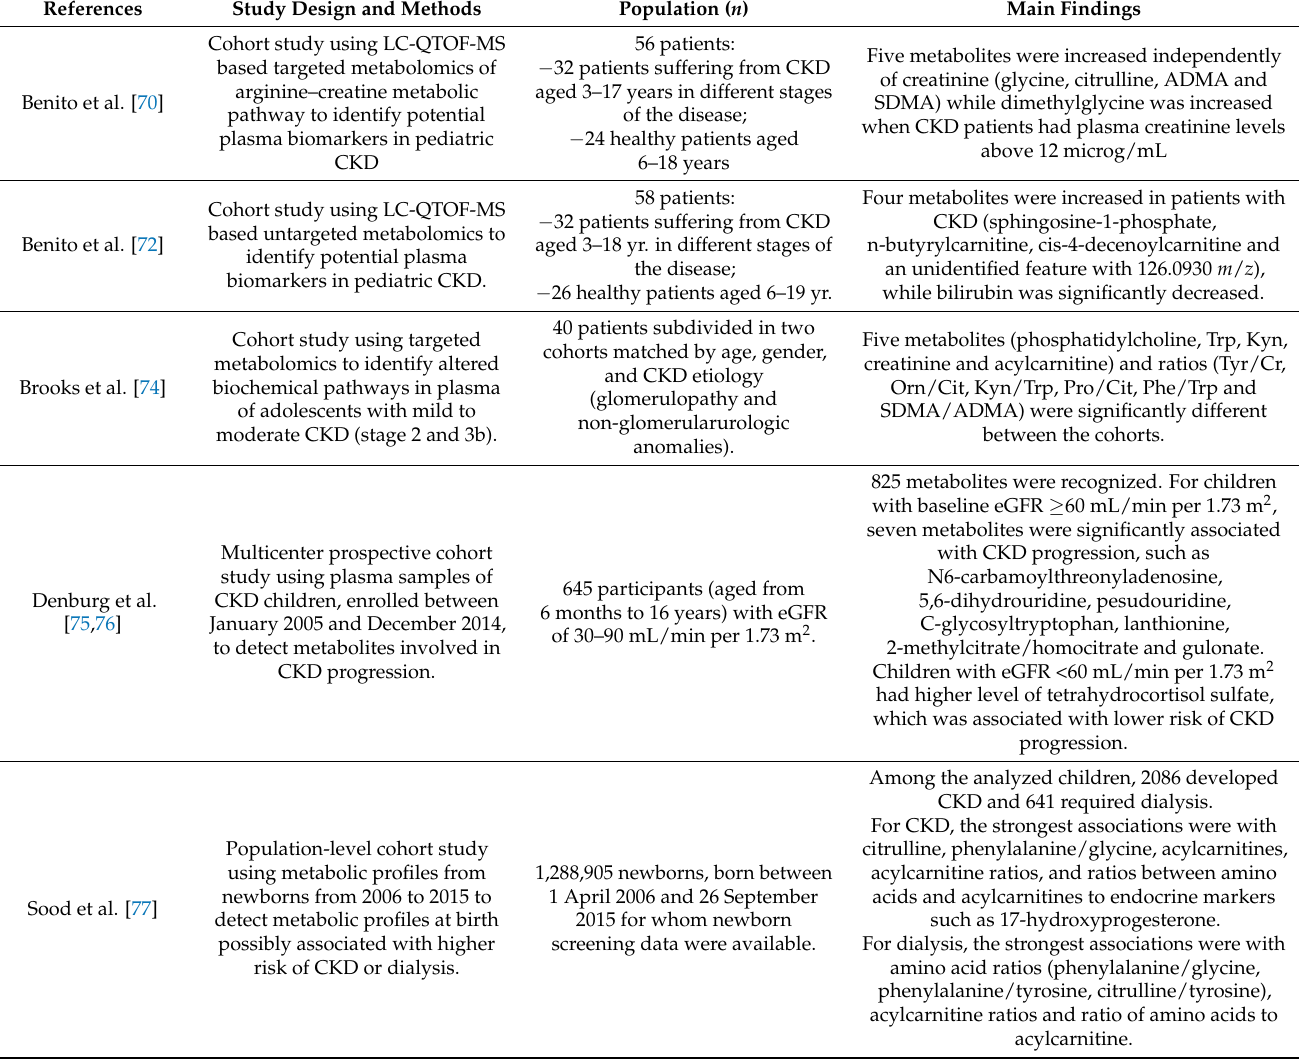
Table 3. Main findings of the omics studies in children with